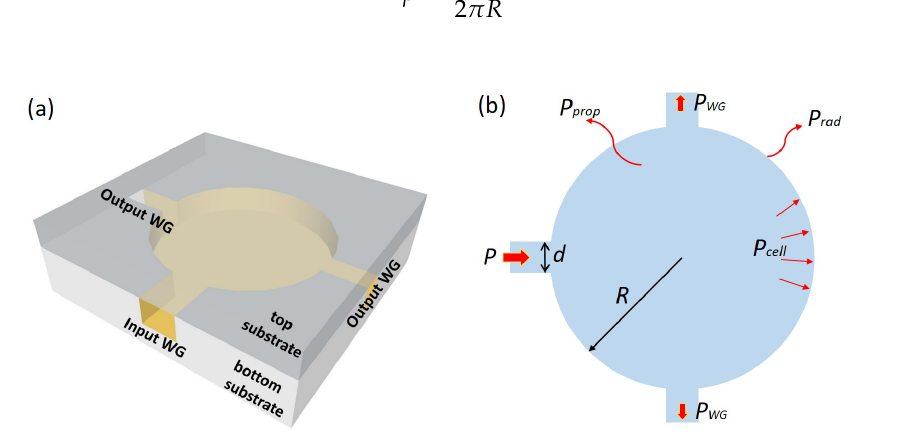
Figure 2. ( a ) 3D schematic of the proposed sensor structure. The bottom substrate has a gold-coated hollow cylindrical cavity with one input waveguide and two output waveguides, the upper substrate is a gold-coated planar silicon substrate, the sensor is formed by wafer bonding of both substrates. ( b ) 2D schematic of the sensor, where R is the radius of the circle, d is the width of all access waveguides, P is the power coupled into the cavity, P WG , P rad and P prop are the power coupled to the output waveguides, the power absorbed/radiated at the cavity sidewall, and the power lost during propagation in the cavity,